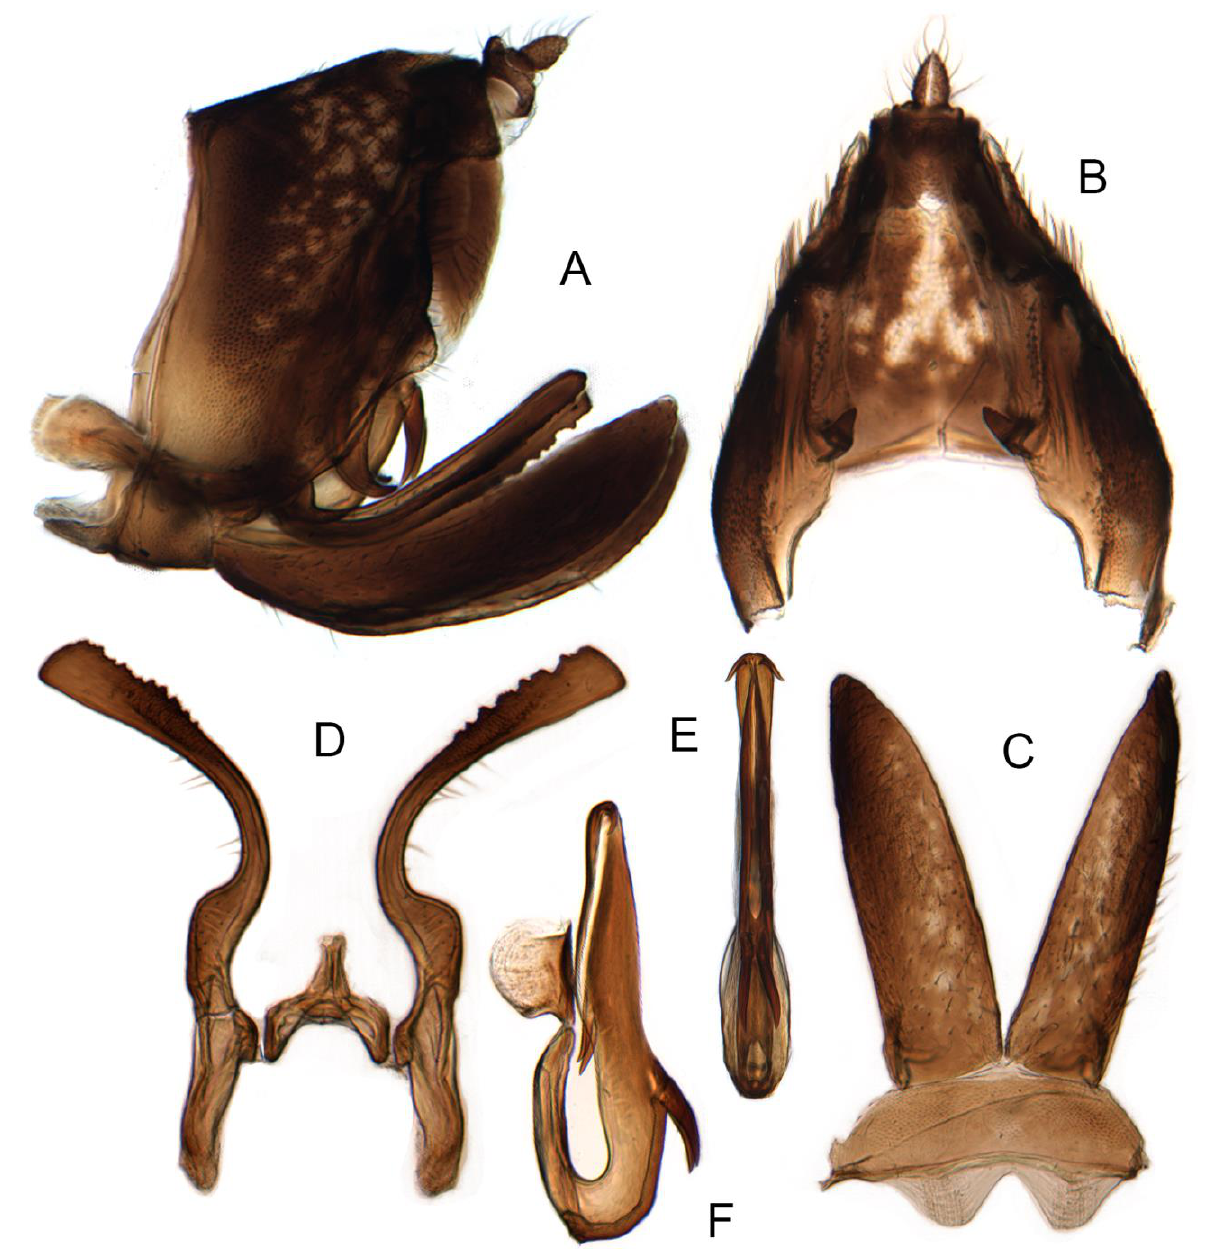
Figure 14. ( A – F ) Planaphrodes laevus . ( A ) pygofer, lateral view. ( B ) genital capsule, ventral view. ( C ) subgenital plates, ventral view. ( D ) styles and connective, ventral view. ( E ) aedeagus, ventral view. ( F ) aedeagus, lateral view.